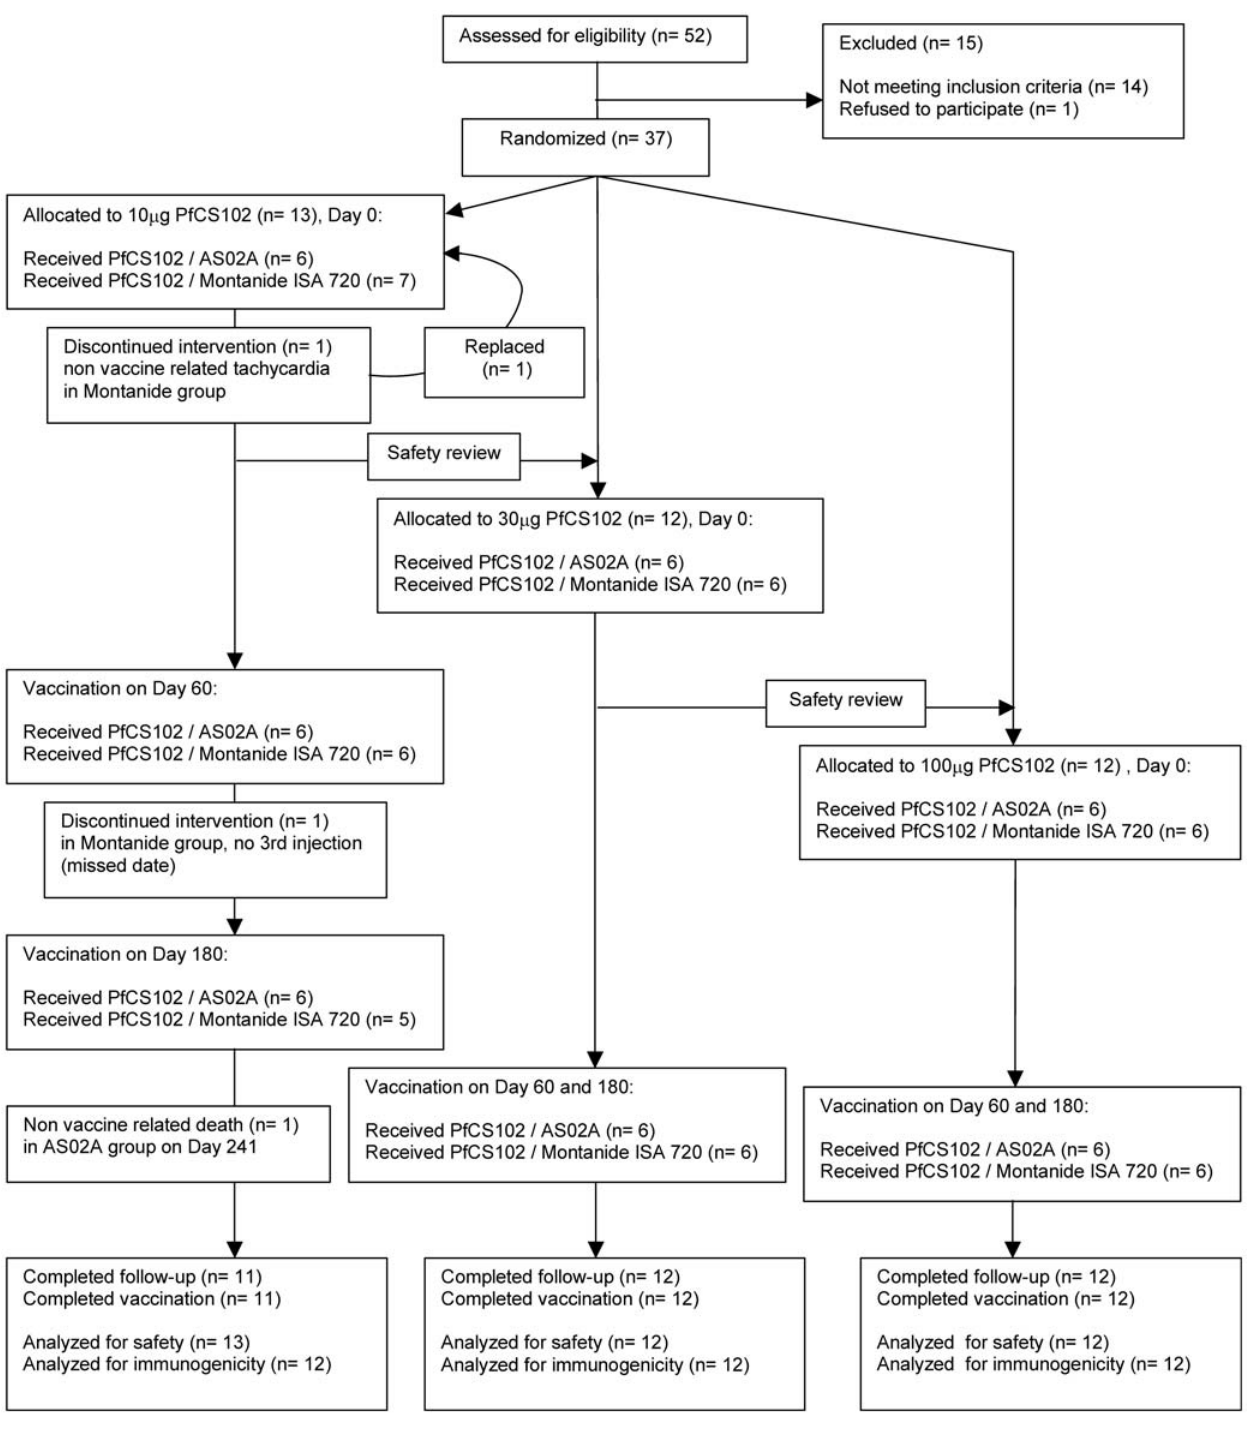
Figure 1. Study flow chart. Design of the Phase I, double-blind, dose-ranging study of 3 vaccine dosing regimens combined to two different adjuvants AS02A and Montanide ISA 720. For each dose, volunteers were randomized by blocks of 12, with 6 individuals per adjuvant. Volunteers were seen 2 and 30 d after the first injection, 2 and 15 d after the second injection and 2, 15, 180, and 360 d after the third injection. A phone call was addressed to all volunteers at d 30 after the 2 nd and 3 rd injection.